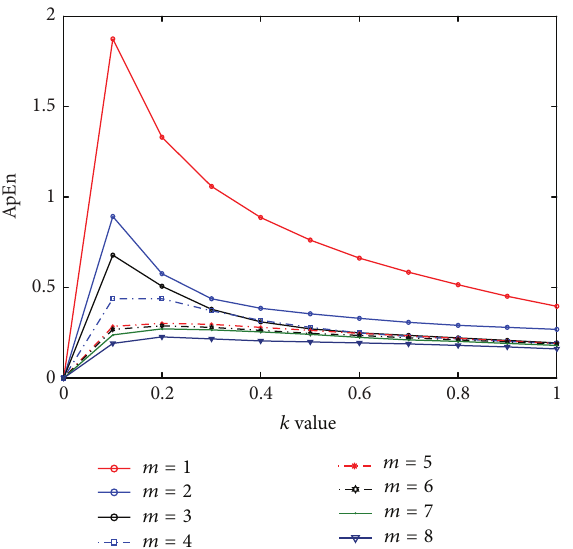
Figure 5: The calculated sample entropy values by different param- eters ( 𝑘 value and 𝑚 ).